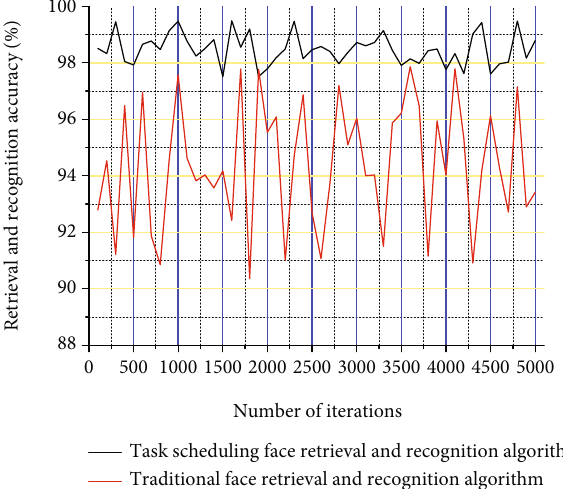
Figure 5: Algorithm retrieval recognition e ff